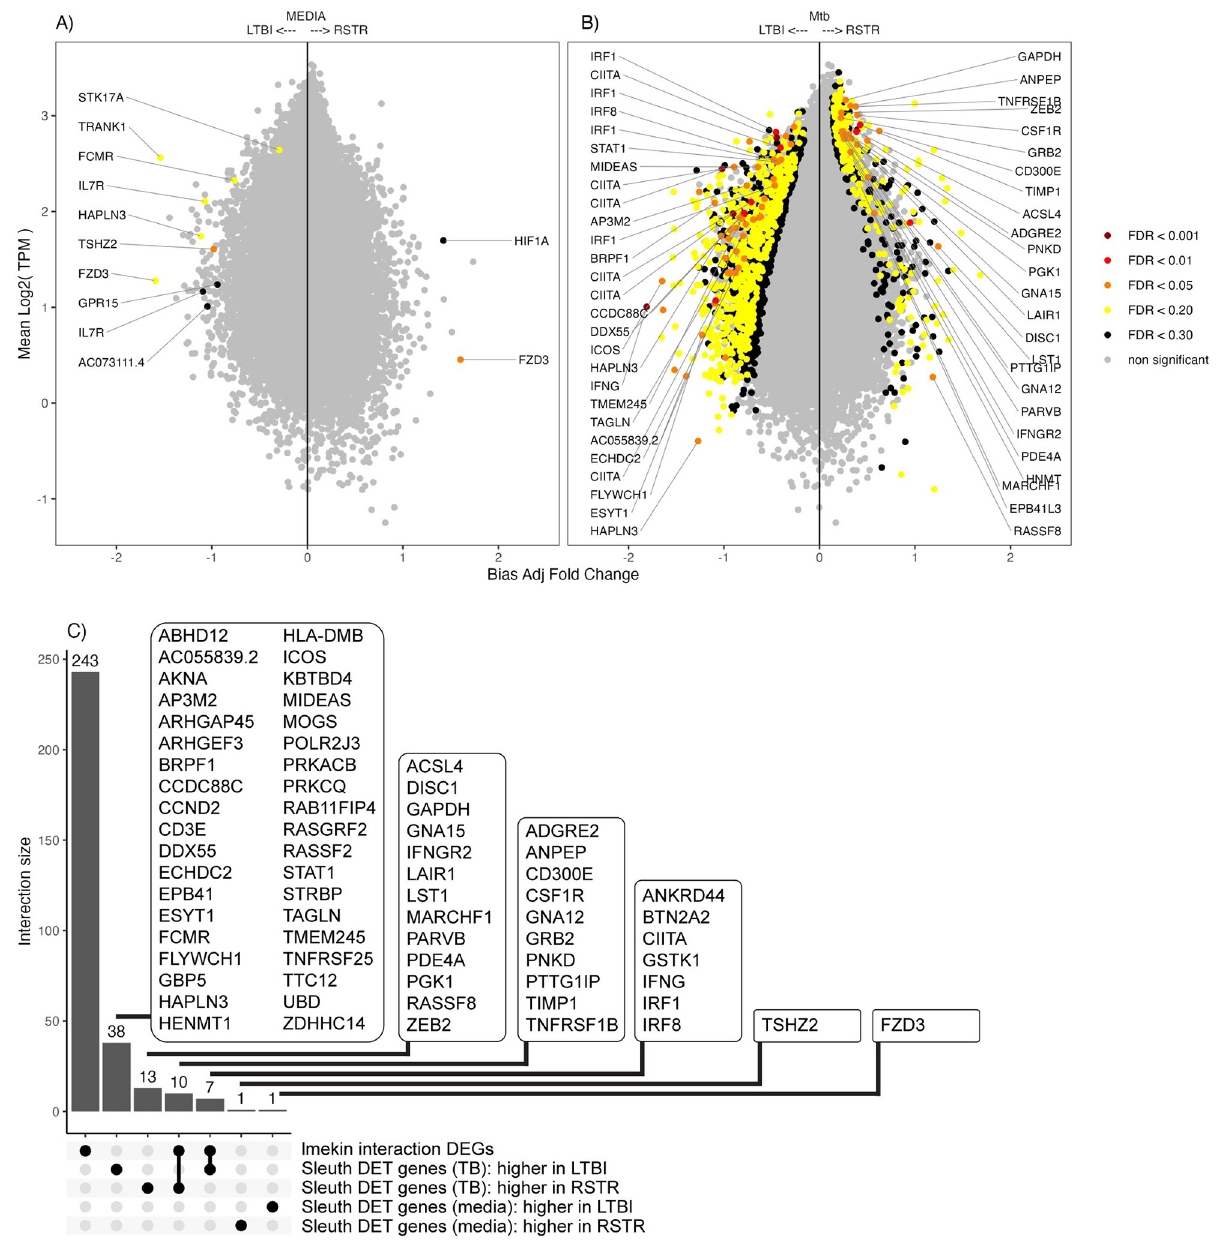
Fig 2. Differential (RSTR—LTBI) transcript isoform expression in media and Mtb-stimulated conditions. For the media (A) and Mtb-stimulated (B) conditions, overall expression (y-axis; log2 transcript count per million [TPM]) is plotted against transcript fold change expression (RSTR—LTBI) where isoforms with positive fold change indicate higher average expression among RSTR donors (x-axis, bias adjusted log2 fold change). False discovery rate [FDR] for the RSTR—LTBI contrast for each condition are indicated by color shading. (C) UpSet plot compares overlap of differentially expressed genes (DEGs) identified previously with a gene-level interaction model (Mtb:RSTR lmekin) and genes with � 1 DET organized according to the indicated subsets. Mtb-stimulation, 79 DETs in 68 genes distinguished RSTR and LTBI phenotypes (FDR < 0.05; Fig 2B, Table 1 and S1B Table). transcripts for CIITA , STAT1 , IFNG , IRF1 and IRF8 (S1B Table), each of which relate to the